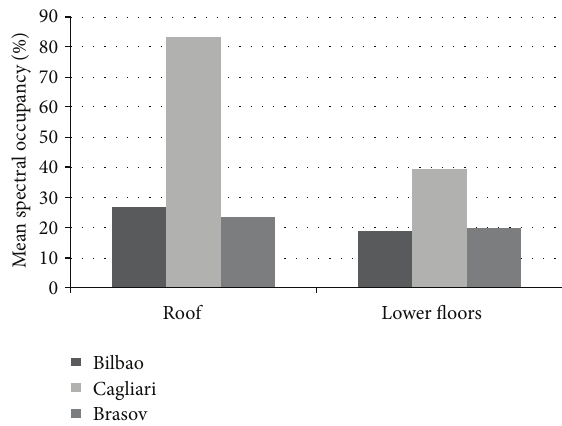
Figure 5: Mean spectral occupancy for the three cities in rural